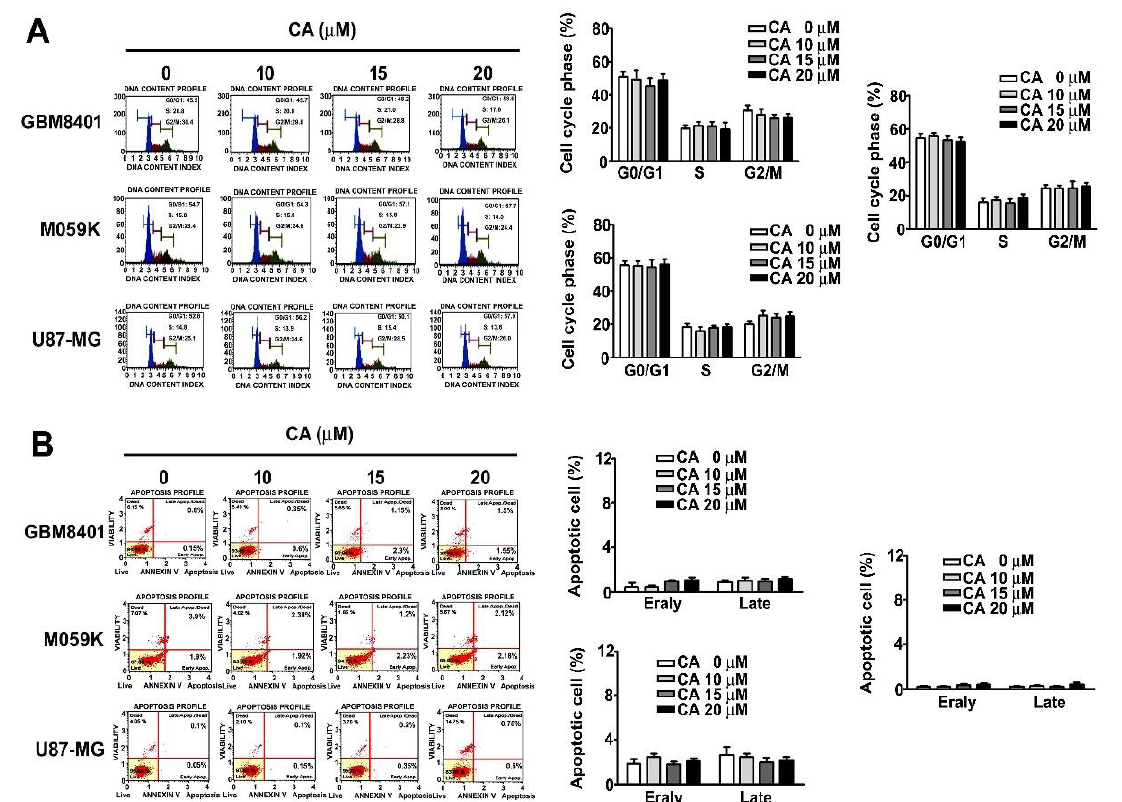
Figure 2. Effect of CA on cell cycle and death of GBM cells. ( A ) GBM cell lines, GBM8401, M059K, U251-MG and U87-MG, were treated with CA at the indicated concentrations for 24 h, and then the cell cycle was detected with PI staining assay by flow cytometry. ( B ) Cell death was measured by Annexin V/PI staining using a flow cytometer and presented as a percentage of the control.